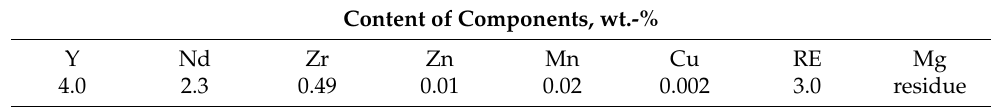
Table 1. Chemical composition of the as-delivered alloy WE43. Content of Components,